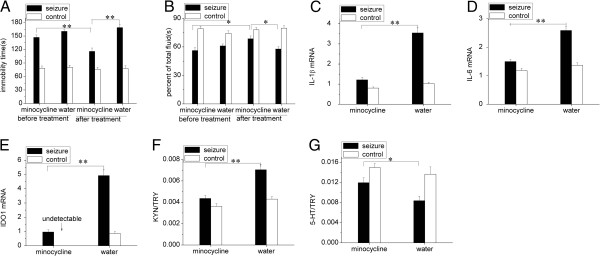
Minocycline blocks chronic temporal lobe epilepsy-induced depressive behaviors and IL-1β, IL-6 and indoleamine 2,3-dioxygenase expression but normalizes tryptophan metabolites in the hippocampus. (A) The duration of immobility during the forced swim test was decreased after minocycline treatment for 2 weeks in chronic epileptic rats (**P < 0.01 versus before treatment by paired t-test; **P < 0.01 versus distilled water treatment by one-way analysis of variance (ANOVA)). (B) Saccharin consumption was also improved in the TPT after minocycline treatment (*P < 0.05 versus before treatment by paired t-test; *P < 0.05 versus distilled water treatment by one-way ANOVA). The mRNA levels of (C) IL-1β, (D) IL-6 and (E) indoleamine 2,3-dioxygenase 1 (IDO1) were downregulated in the hippocampus after minocycline treatment. The hippocampal (F) kynurenine (KYN)/tryptophan (TRY) and (G) serotonin (5-HT)/TRY ratios were normalized. Statistical significance was determined using paired t-test and one-way ANOVA. The data are presented as means ± SEM, n = 5 to 6; * P < 0.05; ** P < 0.01.